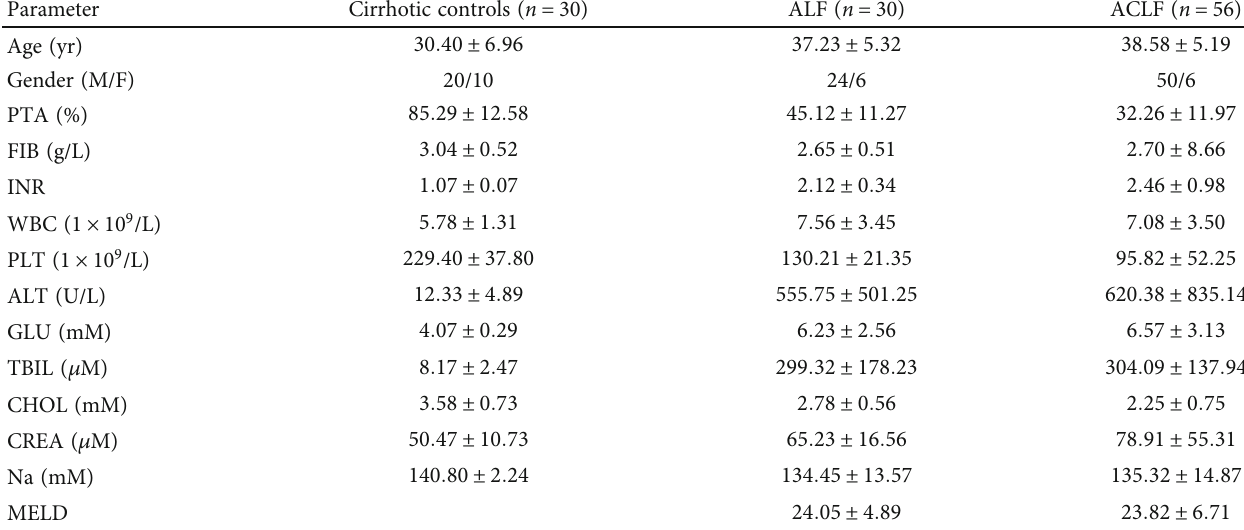
Table 1: Demographic data and clinical characteristics of cirrhotic controls and ACLF patients. Parameter Cirrhotic controls ( n = 30